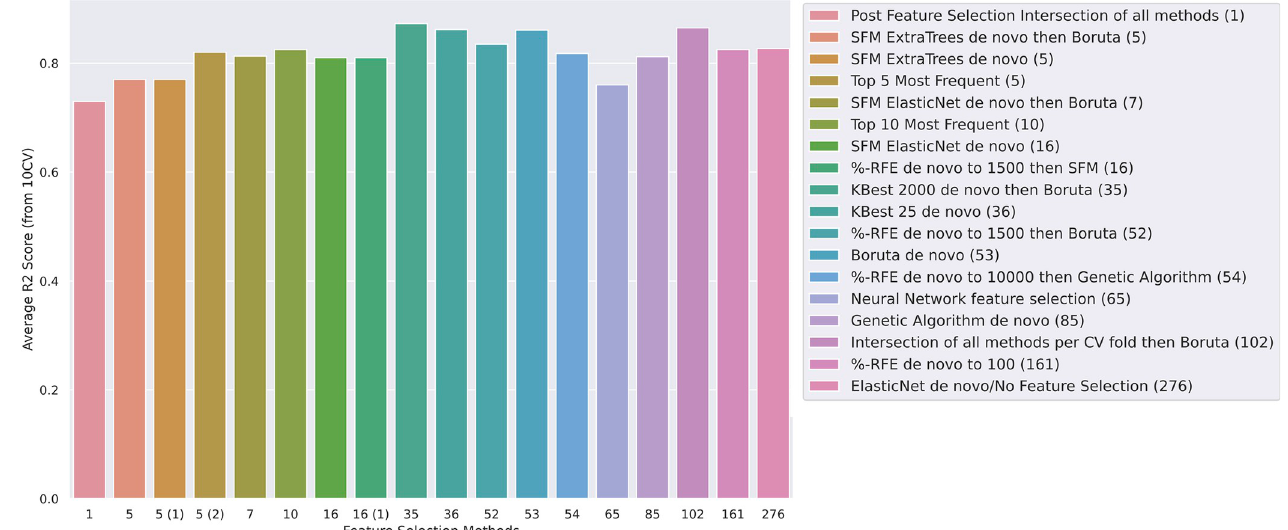
Fig 1. Comparative methods and the number of features used in each model on the x-axis and their average R2 scores on the y-axis. R2 scores are relatively similar across the board despite the number of features needed for prediction varying